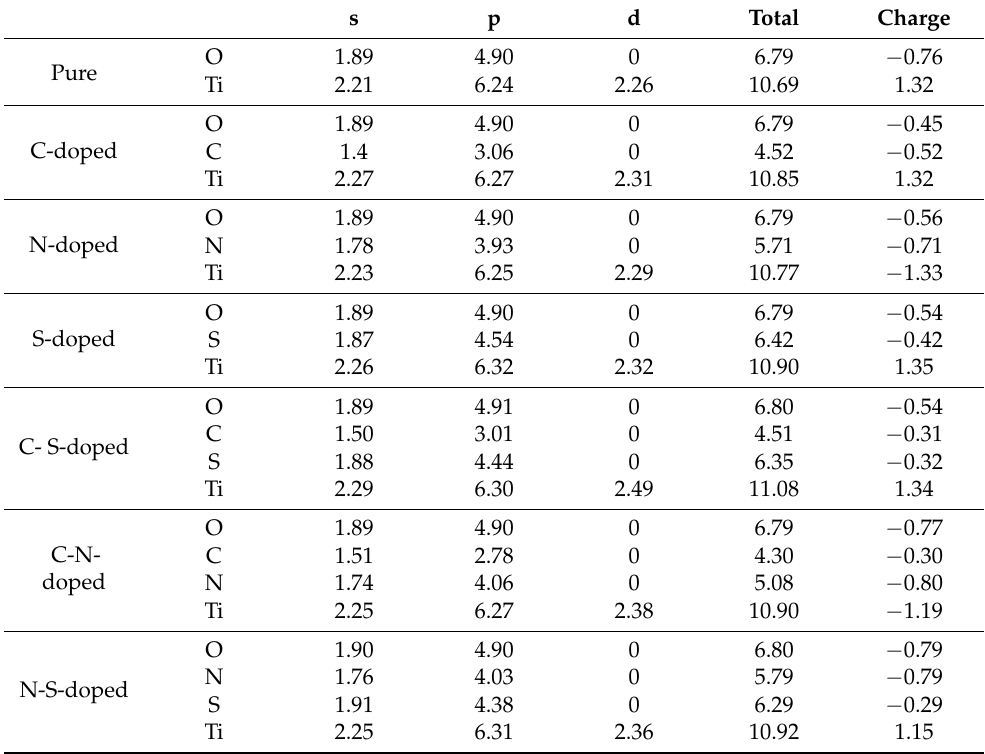
Table 2. Mulliken population analysis of (210) brookite surface for s, p, and d orbitals.